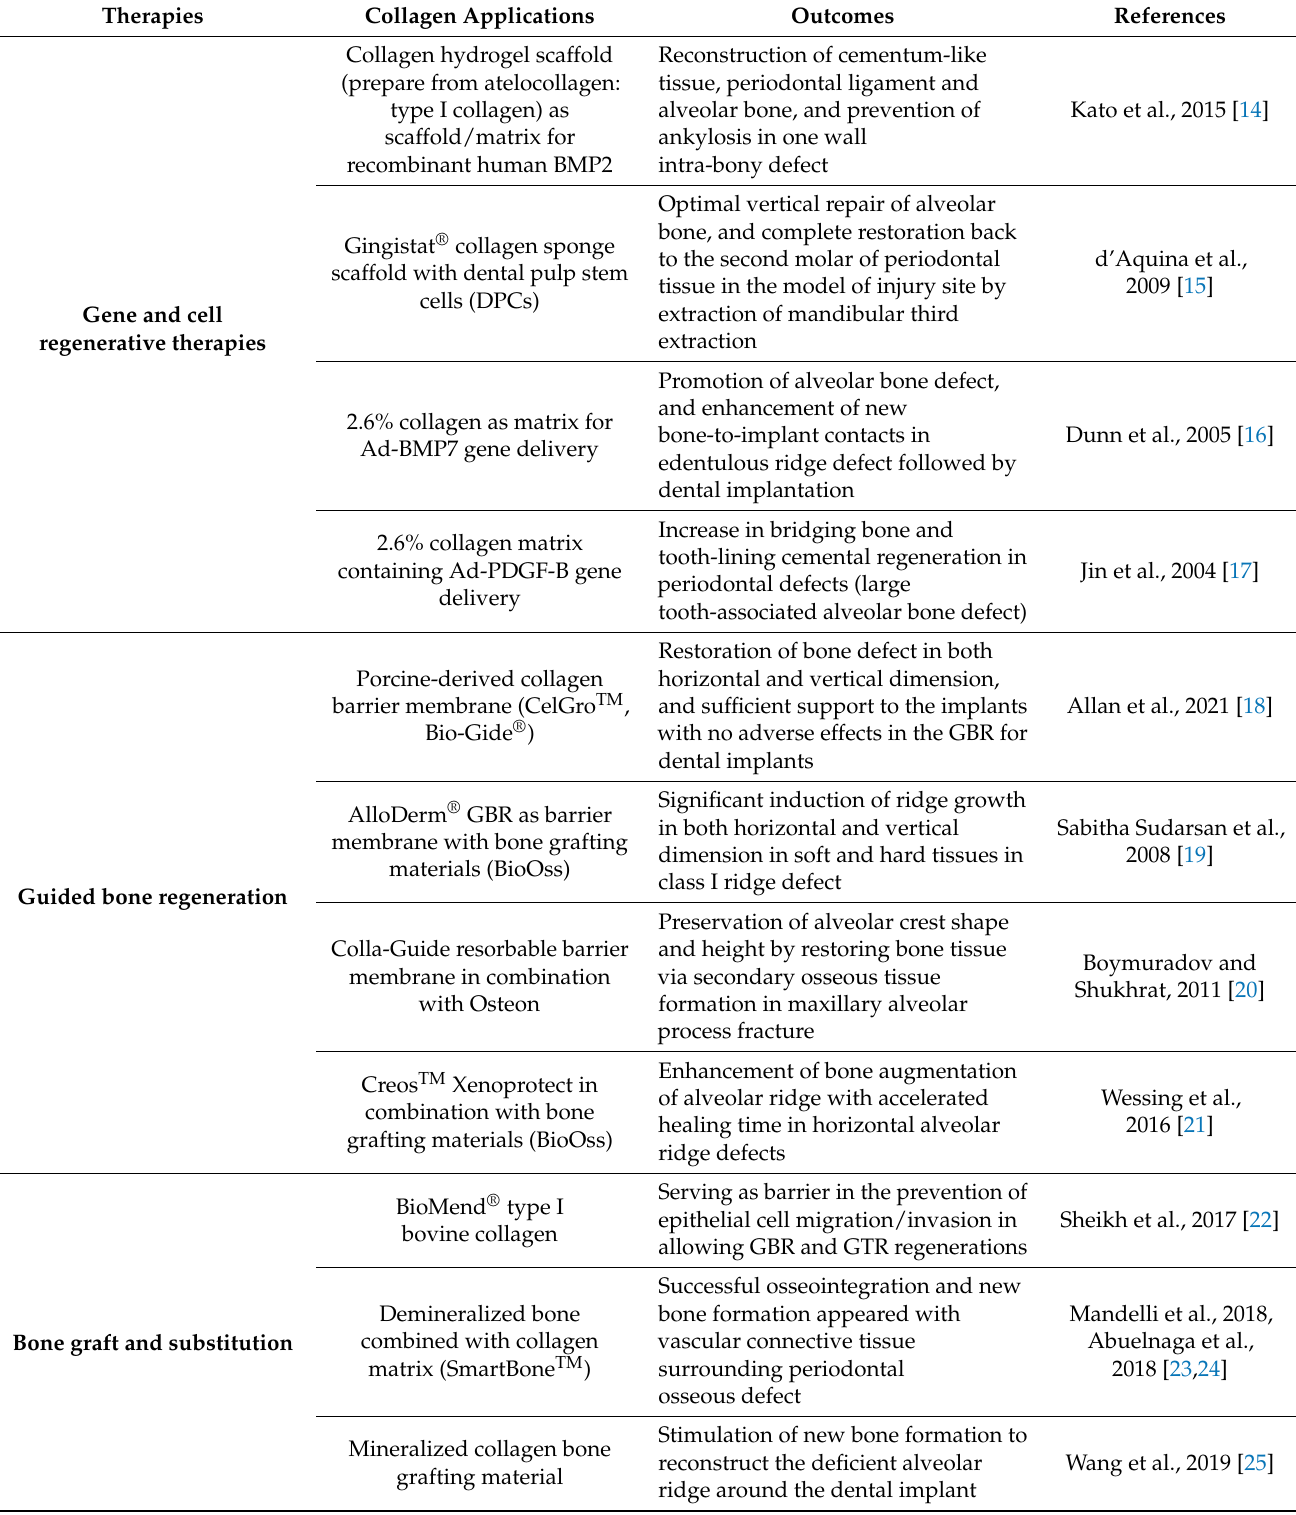
Table 1. Studies of collagen applications and outcomes in periodontal